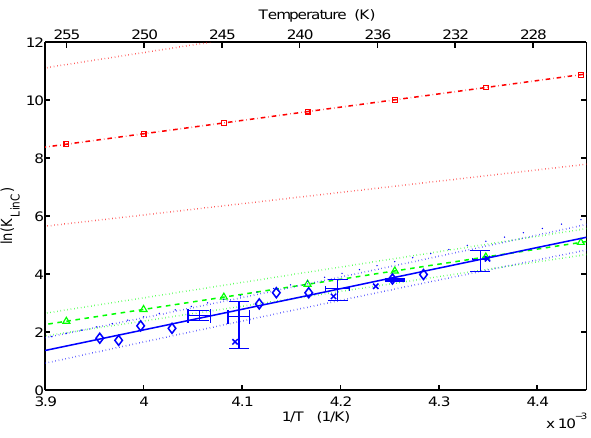
Fig. 4. Natural logarithm of K LinC versus the inverse temperature for HO 2 NO 2 (blue diamonds). When several data points were avail- able mean values are plotted with an uncertainty of two times the standard deviation. The blue, dotted lines give the 95% confidence bounds for the linear fit (blue solid line). The thick blue dots give the maximum error with included competitive adsorption. The blue crosses indicate desorption experiments. The data are compared to the IUPAC recommendation (Crowley et al., 2010) for HONO (green, dashed line with triangles) and HNO 3 (red, dash-dotted line with squares). The dotted lines show the error for HONO and HNO 3 according to the IUPAC